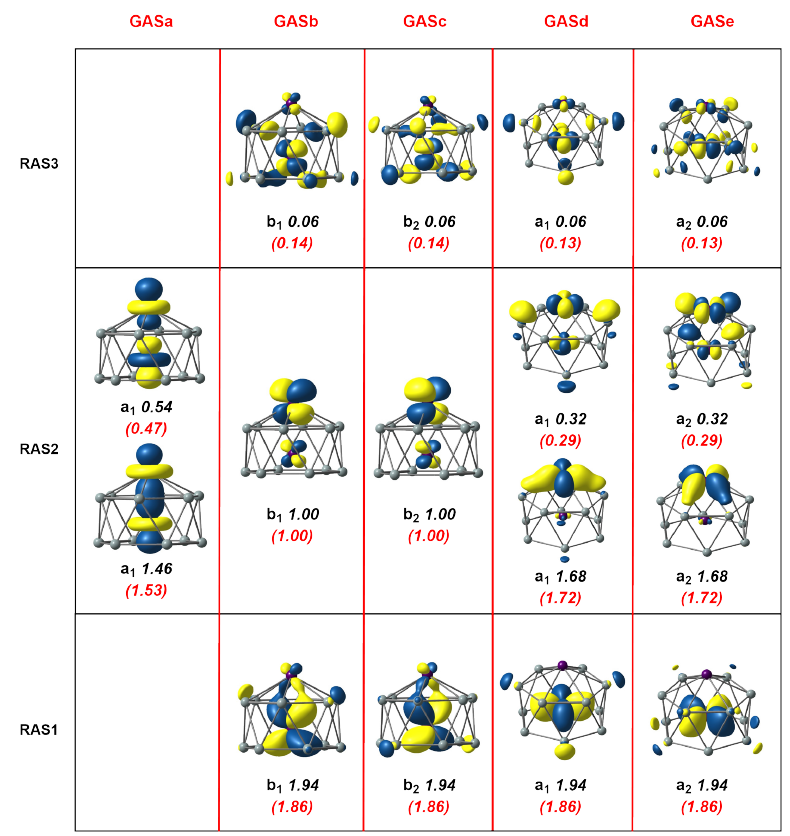
Figure 3. Natural orbitals and occupation numbers for the restricted active space (horizontal) and generalized active space (vertical) of Mn calculation are mentioned in brackets. Calculations on Mn the full C 6 v point